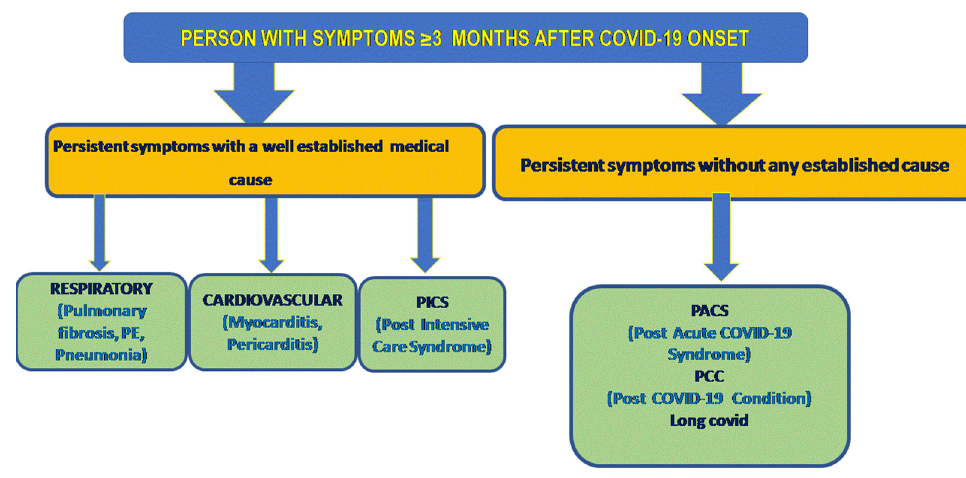
Figure 1. Adjusted algorithm from Mount Sinai 2020 (Tabacof-Rehabilitation management of auto- nomic dysregulation in Post COVID-19 Condition (who.int).